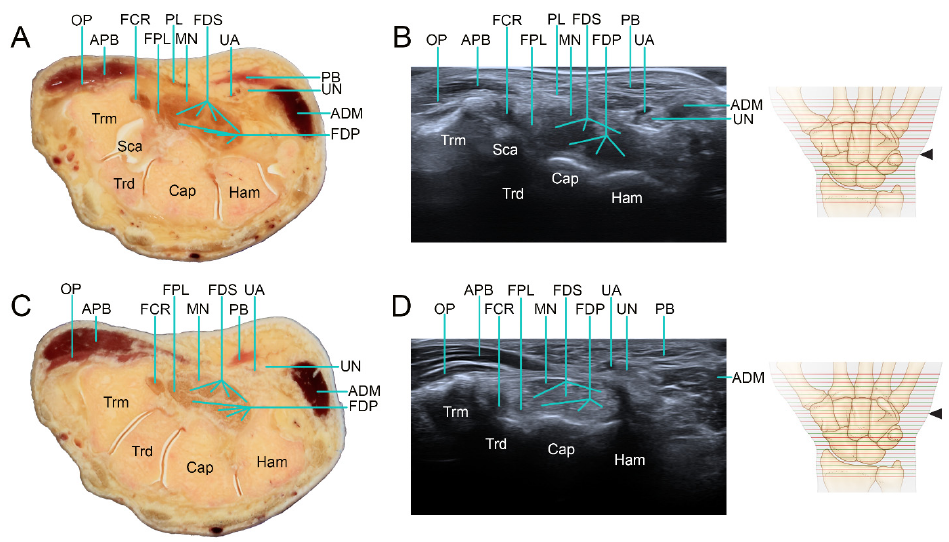
Figure 6. Sectioned images ( A , C ) and corresponding US ( B , D ) images for transverse views at the proximal part of the distal carpal bones. ( A , B ) The distal part of the Sca is observed, and the trapezoid (Trd) appears. The groove and tubercle of the Trm are distinctive. The FCR tendon passes through the groove of the Trm. The FPL tendon is oval in shape, and is just radial to the FDS and FDP tendons. The opponens pollicis muscle (OP) appears to be deep to the APB. The MN is on the second and third FDS tendons and is deep to the PL tendon. The UN and UA are radial to the Pis, anterior to the fourth and fifth FDS tendons, and deep to the PB. ( C , D ) At a more-distal level, the hook of Ham is rising on the ulnar side of the FDP tendons. The Trd becomes larger, and the APB and OP become thicker and extend toward the second FDS tendon. Some PB fibers are